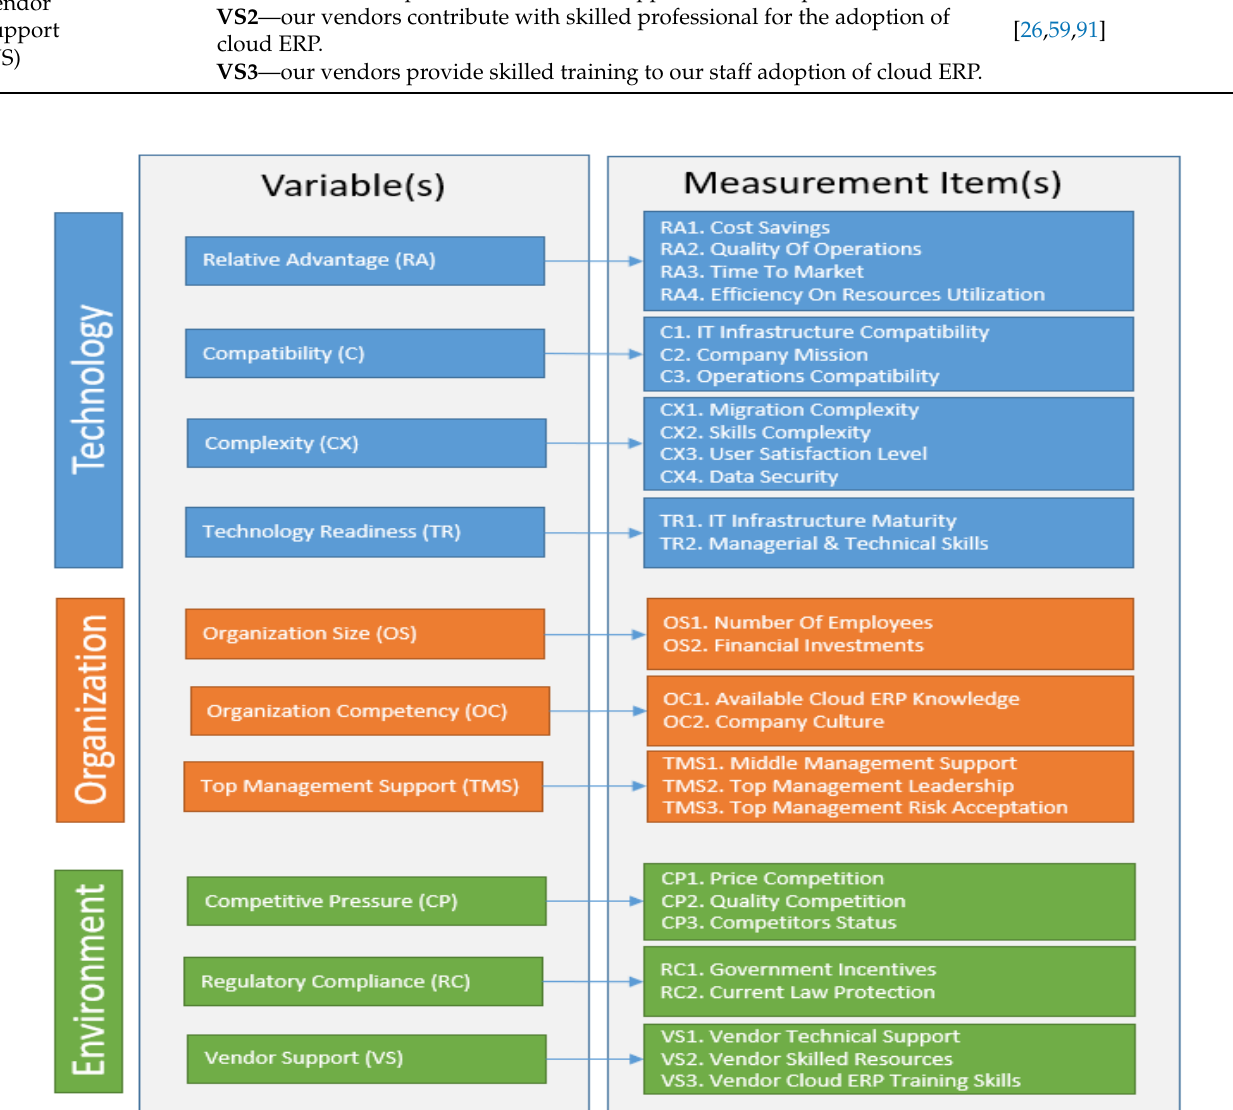
Figure 10. Survey structure.